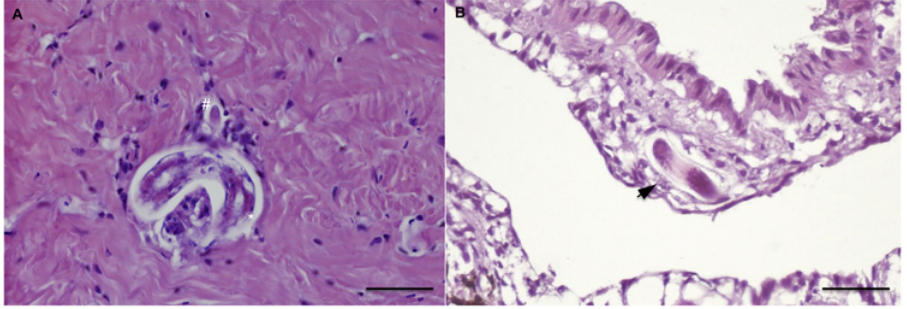
Fig 2. Histopathology: Free larvae of A . abstrusus (21 dpi) in snail foot observed in transverse (hash) and oblique sections (star) in the fibro-muscular tissues. (A); oblique larval section of T . brevior (9 dpi) the subpallial tissue (arrow) (B) (scale bar = 50 μ m;